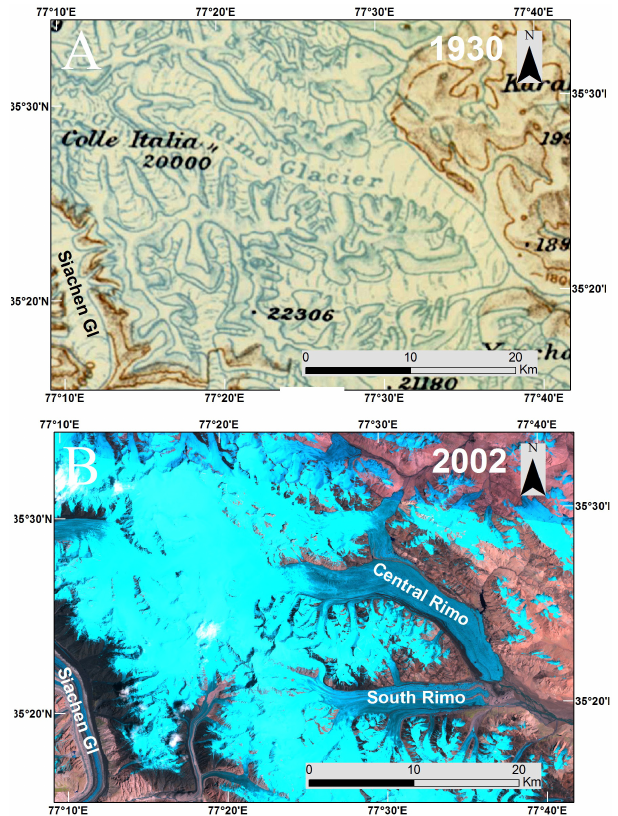
Fig. 2. Rimo Glacier, northeast Karakoram on different time spans; (A) 1930 extent based on Dainelli (1932) map and (B) 2002 situa- tion based on Landsat ETM + (2 August 2002). Map published with the permission of the Royal Geographical Society (with IBG). See Fig. 1 for location in study